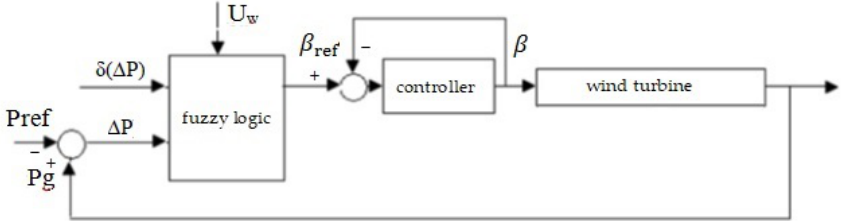
Figure 1. A block diagram of a controller with an algorithm based on fuzzy logic for changing the pitch angle blade of the wind